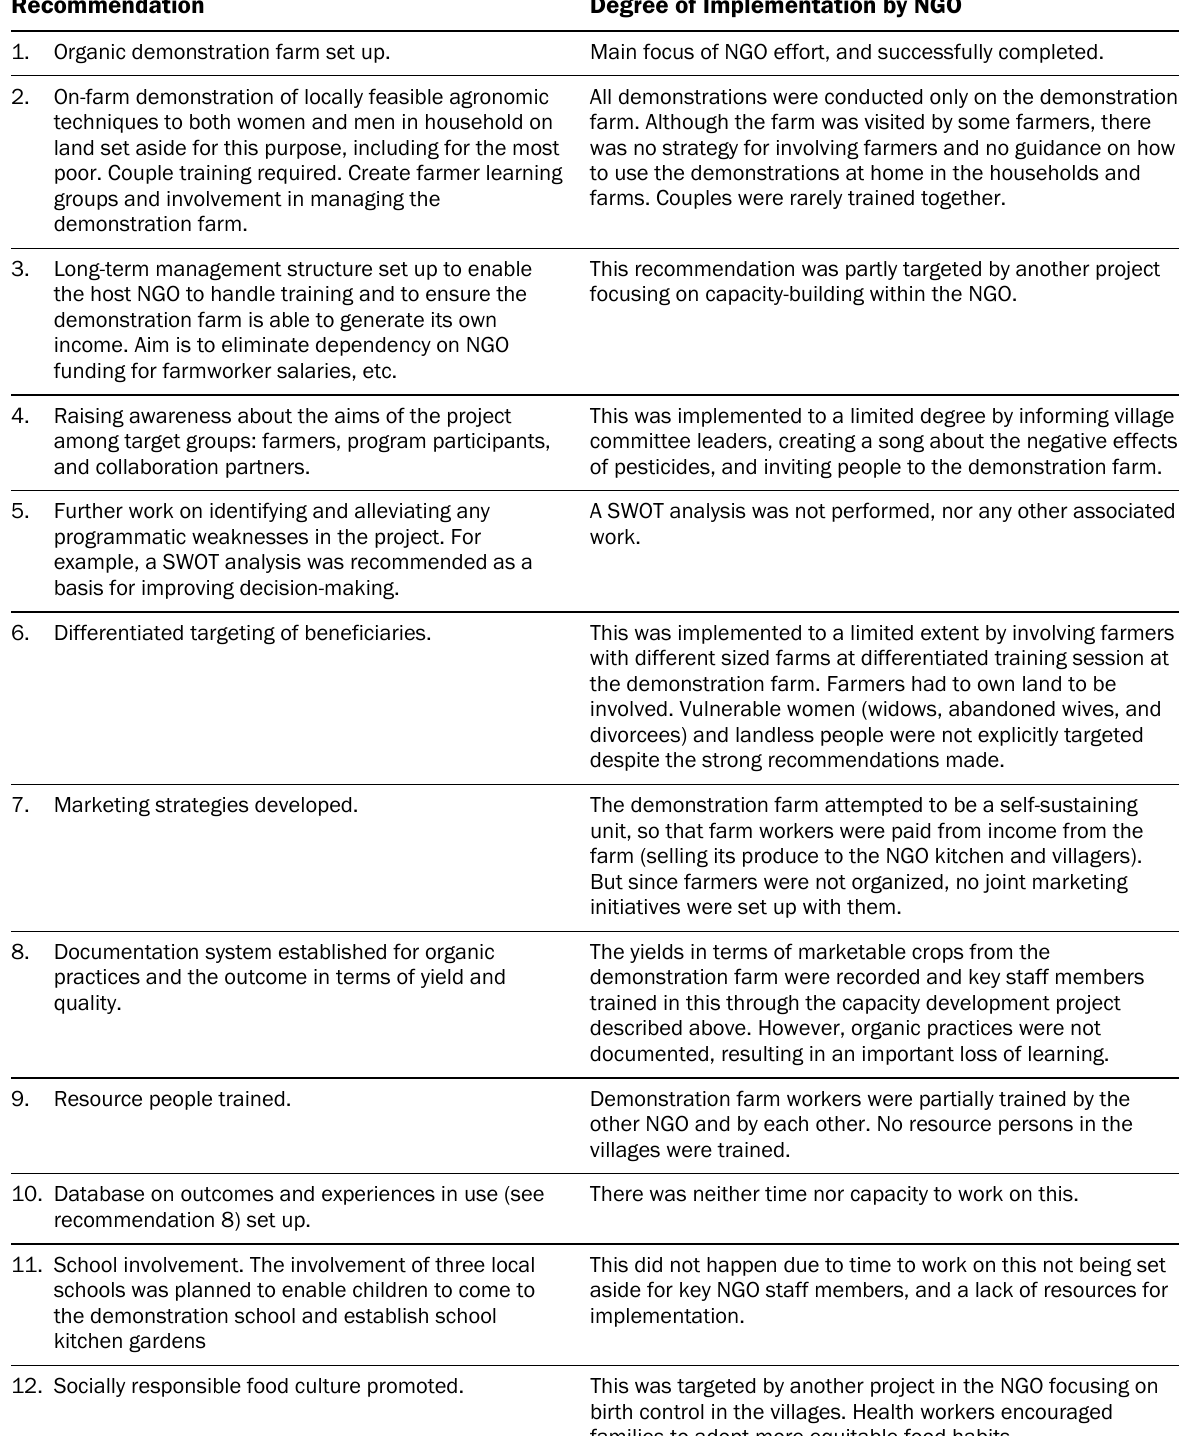
Table 2. Recommendations Made by the Study Team and Degree of Implementation of Each Recommendation Degree of Implementation by